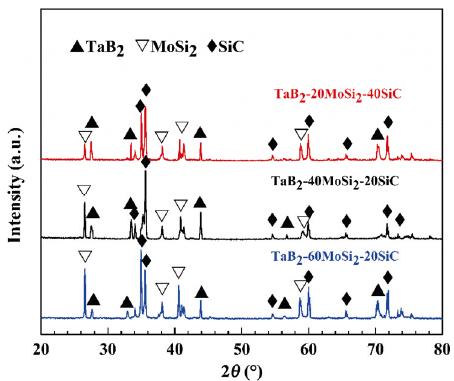
Fig. 2 Surface XRD patterns of the TaB 2 –MoSi 2 –SiC coating fabricated by liquid phase sintering with different mass ratio.